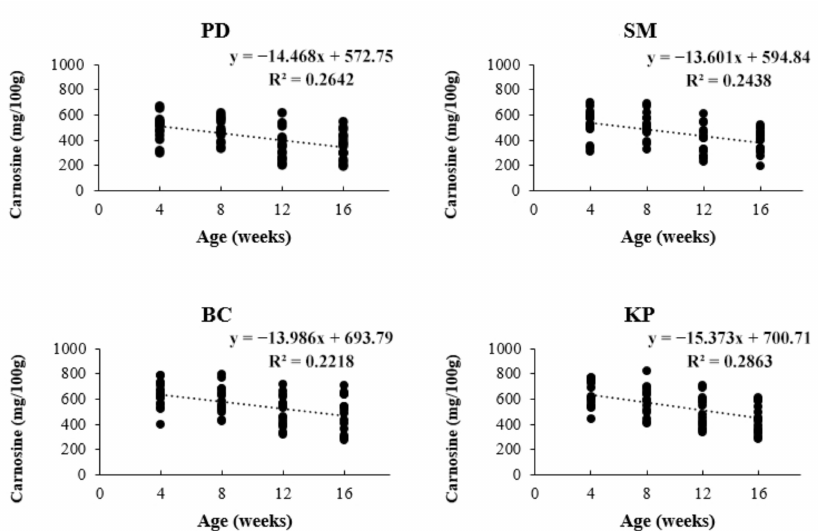
Figure 2. Trends of carnosine content with increasing age. PD = Pradu Hang Dam breed (Thai native chicken); SM = Sri Mok crossbred (crossbred between BC and PD); BC = Black-Chinese breed (black-bone chicken); KP = KU-Phuparn breed (black-bone chicken). A significant negative linearity was observed in this study ( p <